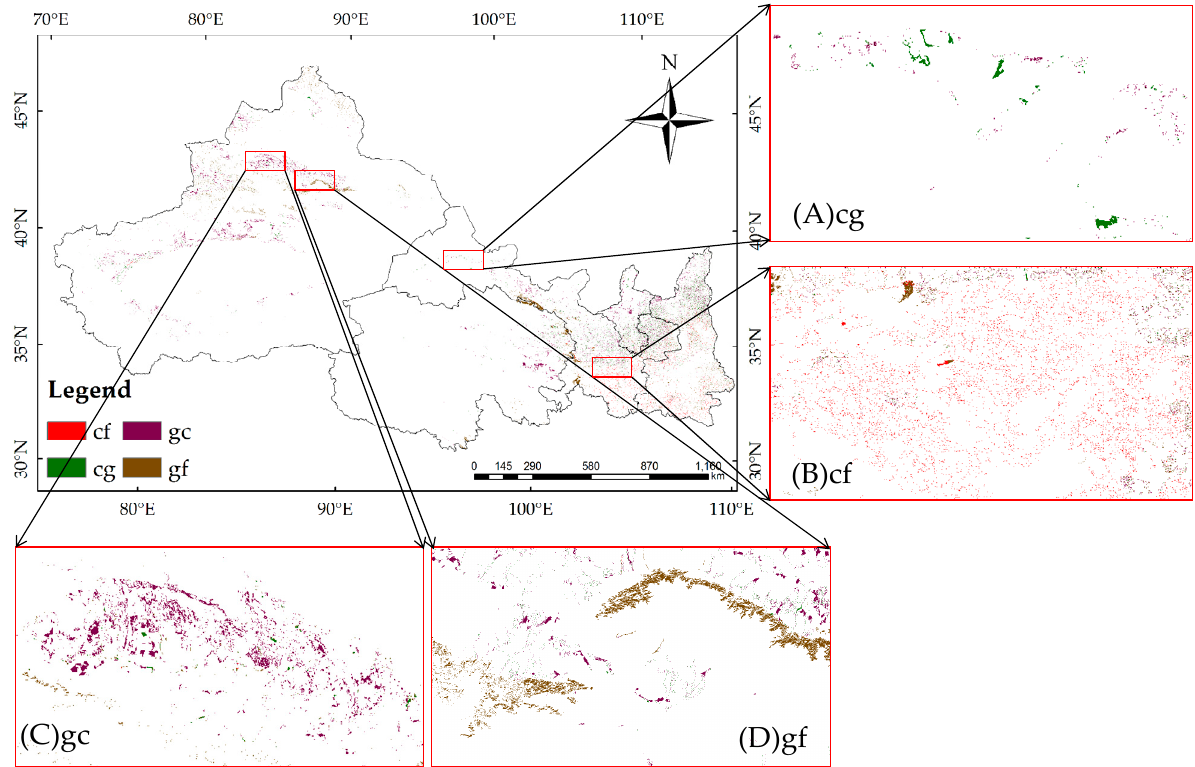
Figure 7. Spatial distribution of vegetation changes from 2010 to 2020. Note: ( B ) cf, change from cultivated land into forest; ( A ) cg, change from cultivated land into grassland, ( C ) gc, change from grassland into cultivated land; ( D ) gf change from grassland into forest.